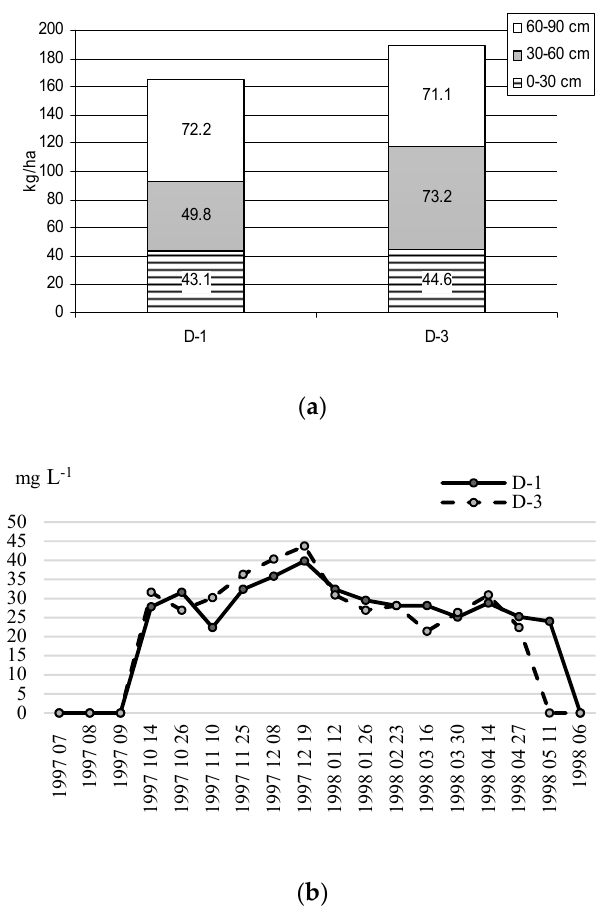
Figure 4. Soil N inorganic in the topsoil and subsoil layers on 28 October 1997 after the 3rd year ley ploughing and winter wheat sowing, in kg ha − 1 in two drainage plots D-1 and D-3 ( a ); measured values of NO 3 -N in mg L − 1 in drainage runoff in the same plots with zero fertilization ( b ) in 1997–1998 hydrological year (data obtained in Akademija site previously not published).